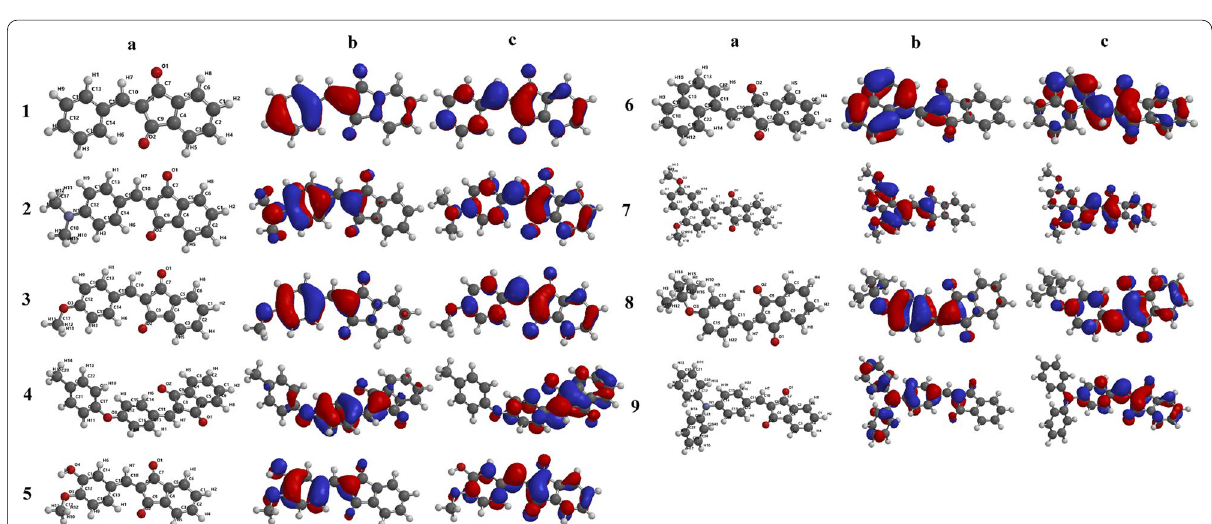
Fig. 2 a Optimized structures, b HOMO and c LUMO surface maps of compounds 1 to